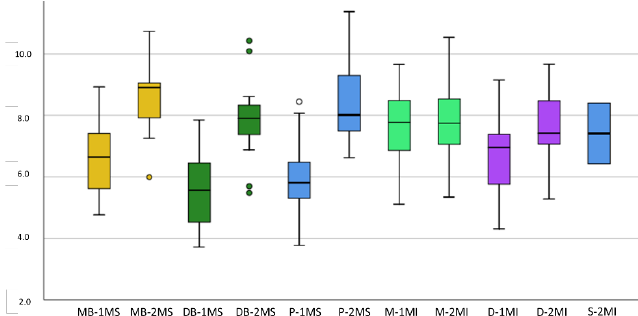
Figure 7. Box plot for comparison of root length: Axis Y: root length (mm), Axis X: 1MS (Maxillary 1st molar), 2MS (Maxillary 2nd molar), 1MI (Mandibular 1st molar), 2MI (Mandibular 2nd molar), MB (mesiobuccal), DB (distobuccal), P (palatal root), M (mesial), D (distal), S (supernumerary).